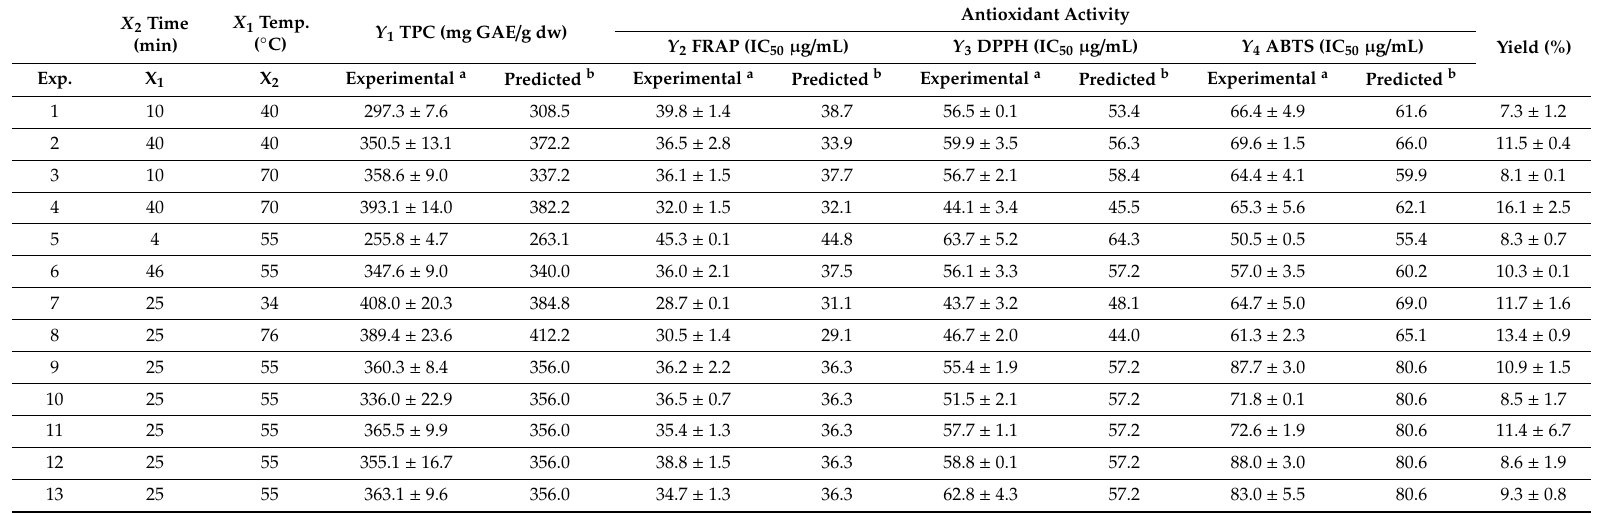
Antioxidant Activity